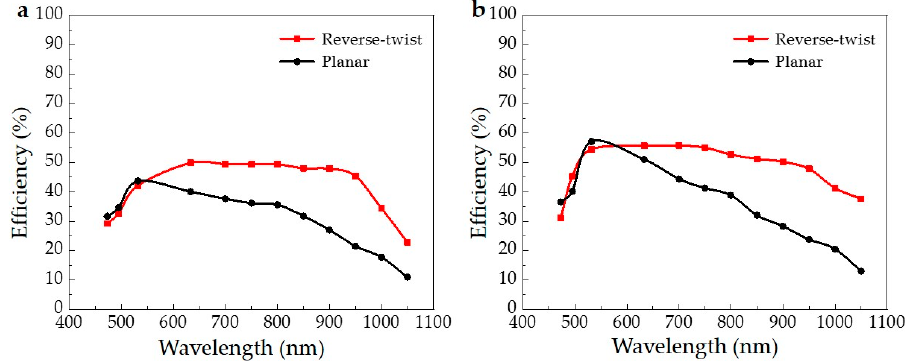
Figure 5. The dependencies of diffraction efficiencies on wavelength. ( a ) DVGs and ( b ) DQPs.